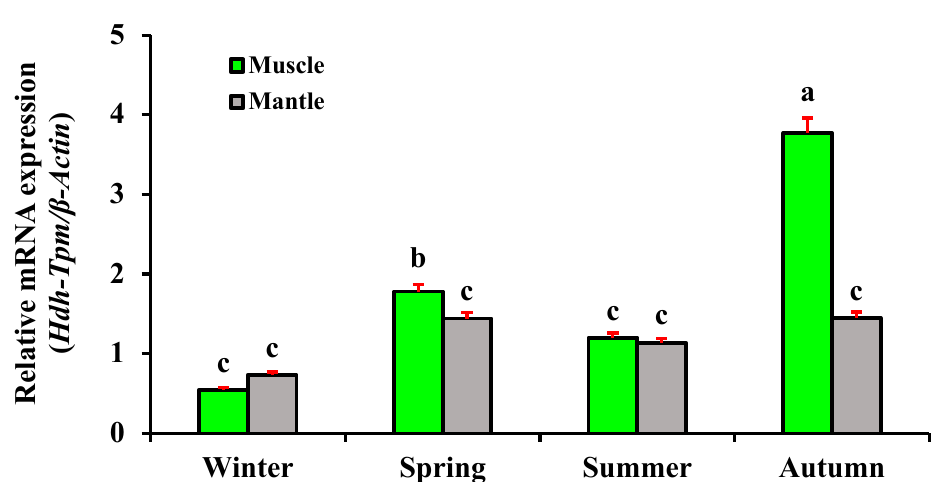
Figure 11. Expression of Hdh-TPM according to the season in mantle and muscle tissues of Pacific abalone H. discus hannai . Significantly different levels ( p < 0.05) are denoted by different letters.